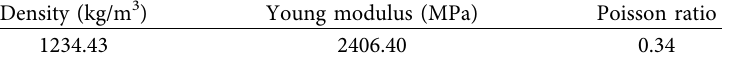
Table 7: Geometric characteristics of the breakable ball pack.